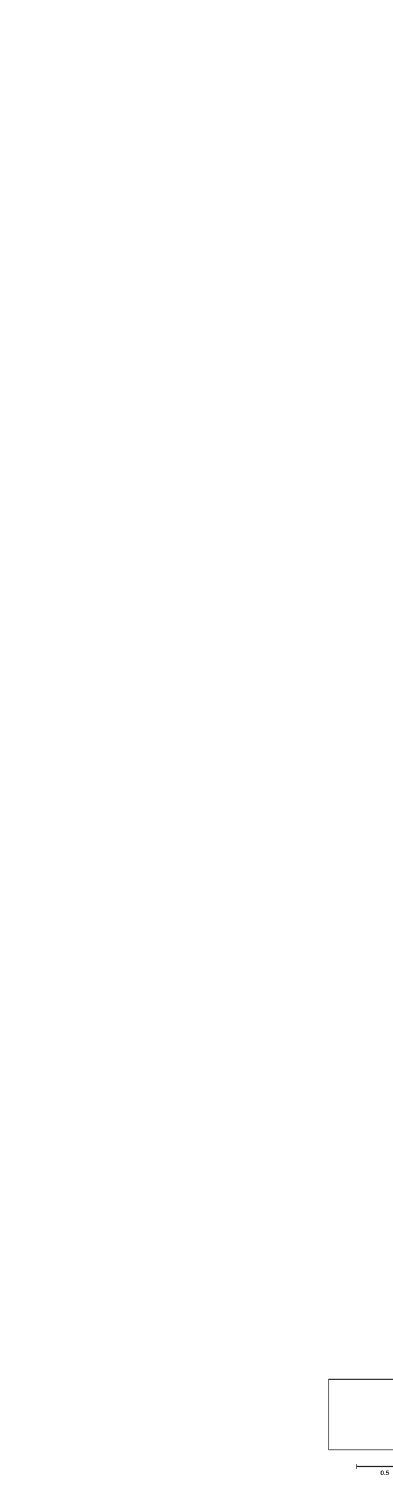
FIGURE 2 | Phylogenetic analysis based on full-length VP1 of CVA6. The 37 CVA6 isolates from this study and 90 representative strains of CVA6 from GenBank and CVA10 prototype strain CVA10/Kowali/AF081300 were used to construct phylogenetic trees based on the full-length VP1 sequence (915 nucleotides) (Test of Phylogeny: Bootstrap method, number of Bootstrap Replications: 1,000 Mode: Kimura 2-parameter model), showing a bootstrap value of > 70%. ▲ indicates the CVA6 strain isolated in this study.